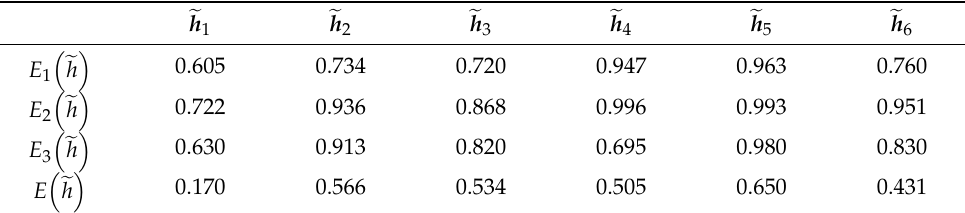
Table 3. Interval-valued hesitant fuzzy entropy